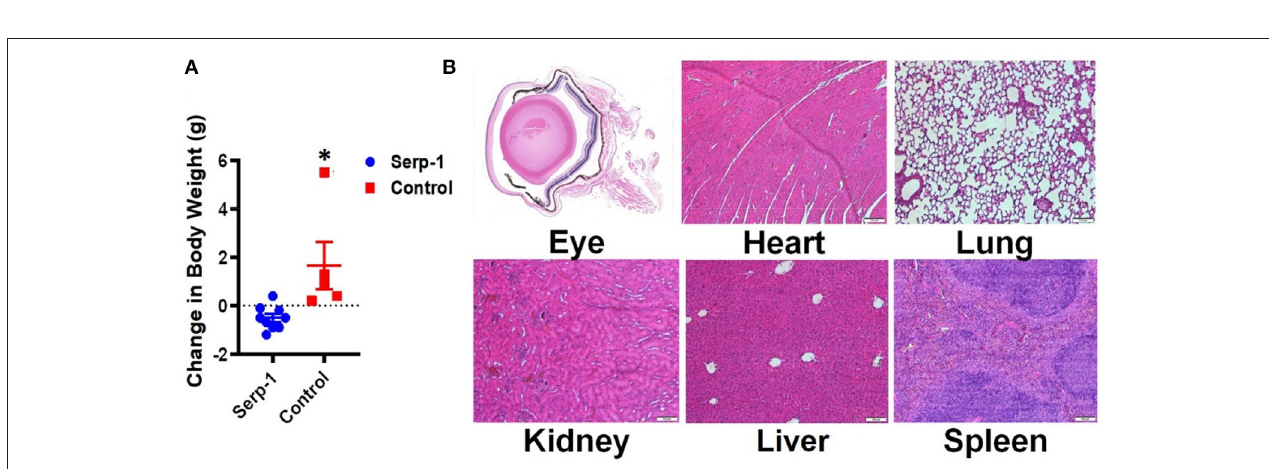
FIGURE 4 | Repetitive application of Serp-1 produces no obviously toxic effects. (A) Changes of body weight before and after experiments were measured and calculated ( n = 5 for control group, n = 9 for Serp-1 group. * P < 0.05). (B) Histochemical analysis of eye cross-sections shows reduced rates of inflammatory cell infiltration and swelling of the cornea in Serp-1 treated mice. Enlarged images of the corneal region of two mice visibly show more swelling and a higher presence of inflammatory cells in the control mice. Inflammatory cell nuclei are stained by the deep-purple spots marked with white triangles in the light pink stromal layer of the